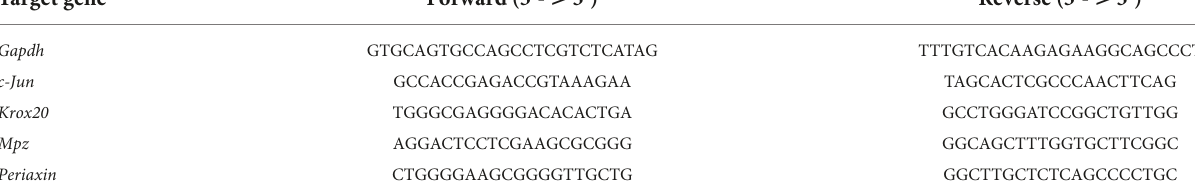
TABLE 2 Rat primers used for qPCR. Target